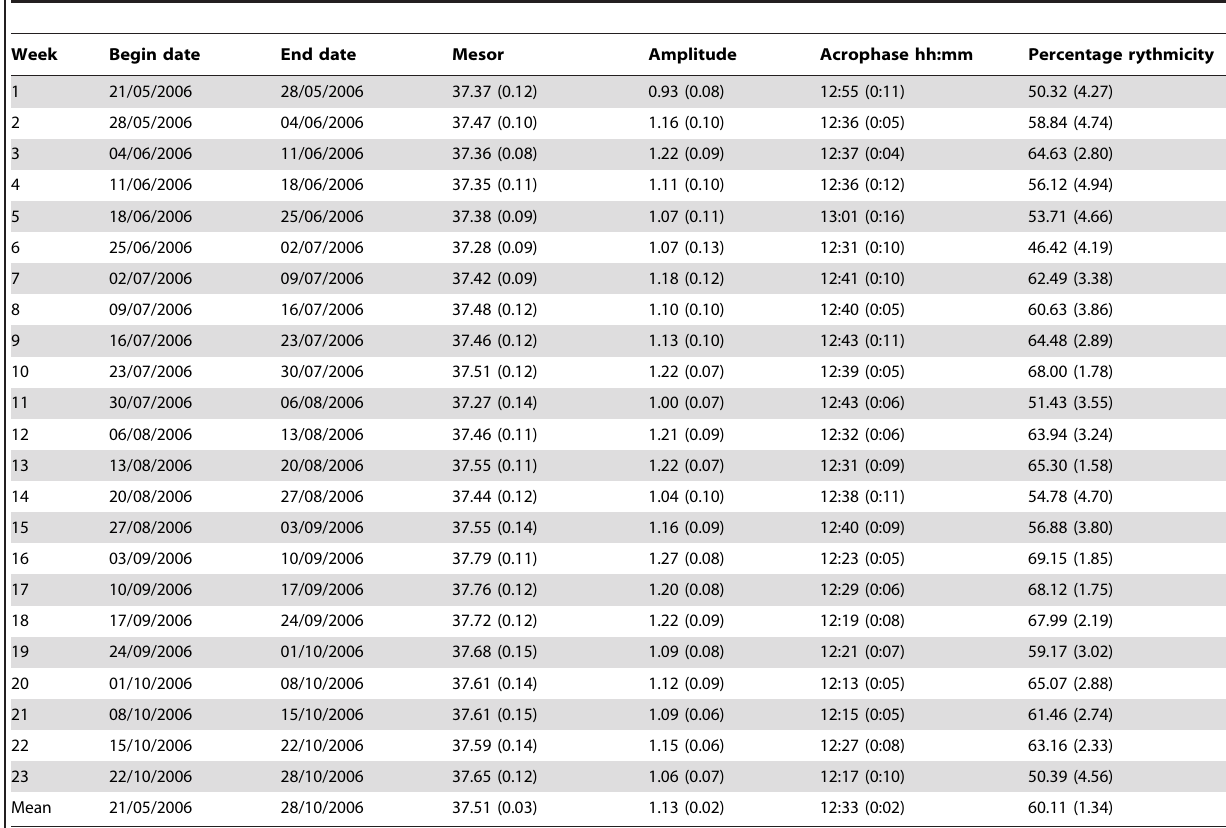
Table 1 . Mean ( 6 SE) of the mesor ( u C), amplitude ( u C), acrophase (time hh:mm) and percentage rythmicity obtained from 24 h cosine functions of hourly T b recordings of eight Cape ground squirrels during a 23-week sampling